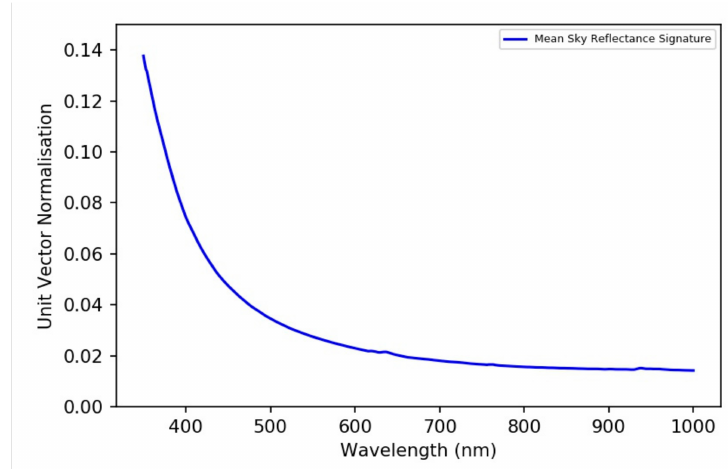
Figure 14. FR Spectroradiometer signature of blue sky. Signature is a mean of 12 sky signatures converted to unit vector